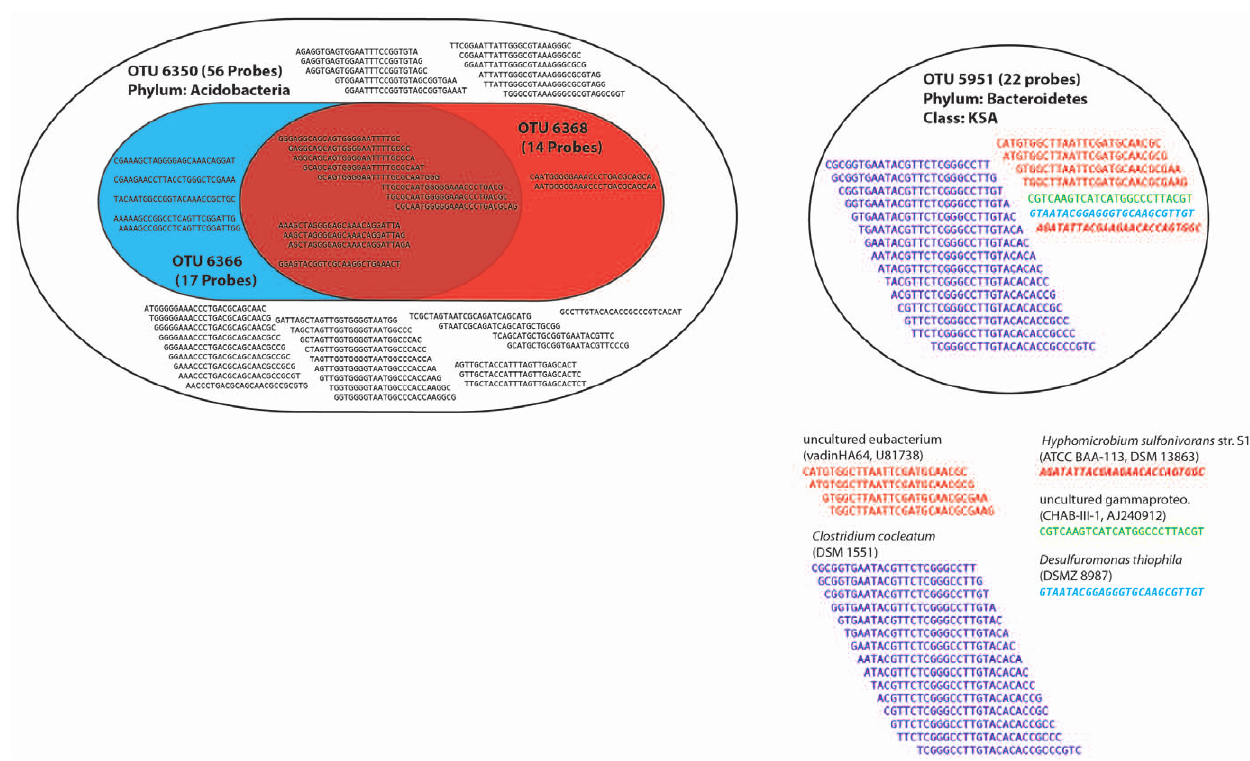
Figure 1. Two examples of probe sharing between OTUs. On the left are shown the 56 probes that represent the OTU 6350. Probes shared with OTU 6368 are shown in the red shape, while those shared with OTU 6366 are shown in blue. The intersection of the red and blue shapes shows probes shared by all three OTUs (centre circle). All 14 and 17 probes (100% of the probe sets) for 6368 and 6366, respectively, can be found in the probe set for OTU 6350. On the right is illustrated how the complete 22 probe, probe set for OTU 5451 can be assembled from probes representing other OTUs.